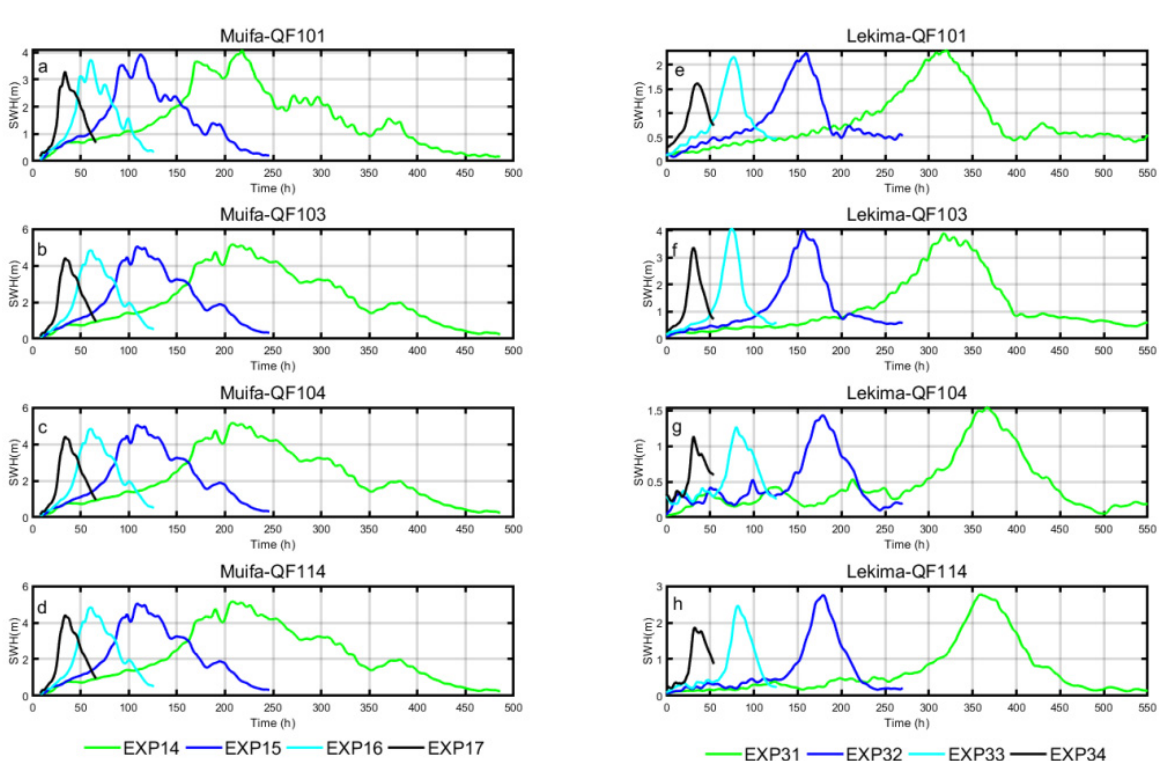
Figure 16. Significant wave height associated with the translation speed over time at ( a ) QF101, ( b ) QF103, ( c ) QF104, and ( d ) QF114 for Typhoon Muifa and ( e ) QF101, ( f ) QF103, ( g ) QF104, and ( h ) QF114 for Typhoon Lekima.